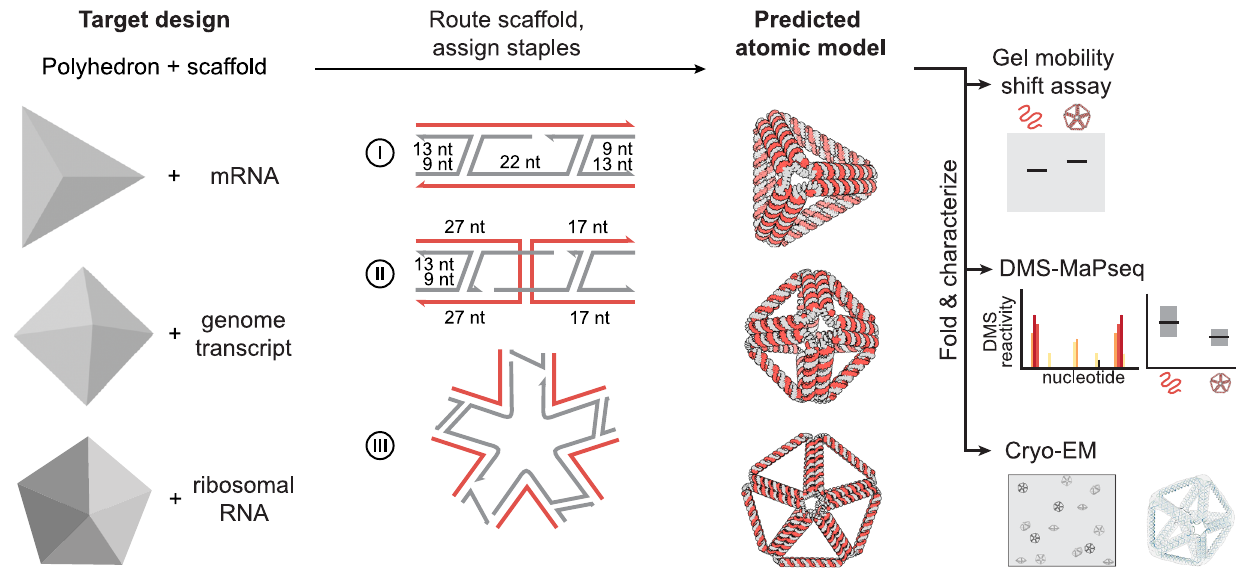
Fig. 1 | Design overview for A-form DX wireframe origami. Starting with a target polyhedron and scaffold sequence as inputs, we algorithmically route the scaffold through the polyhedron and route and assign staple for I. edges with no scaffold crossover, II. edges with a scaffold crossover, III. vertices, and predict an atomic modelstructure. The basic routing scheme for edges with 4 helical turns isshown,